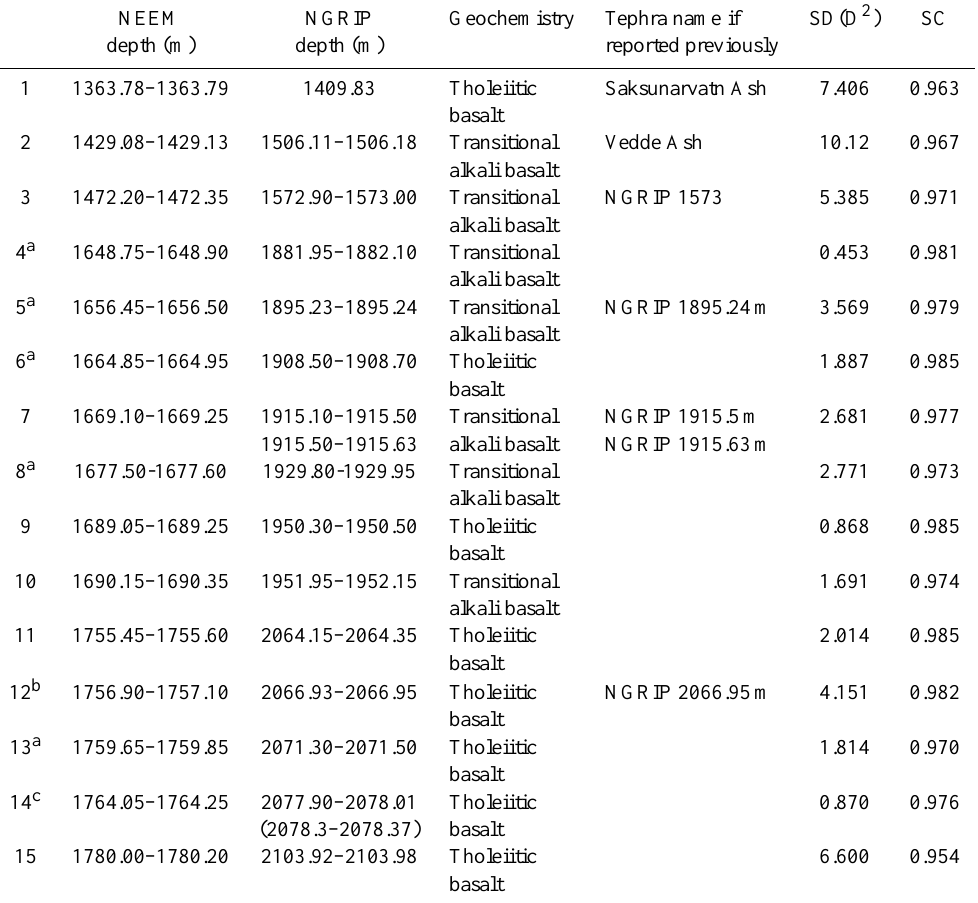
Table 1. Summary table of tephra horizons identified in the NEEM and NGRIP ice cores. Horizons used for the timescale transfer are marked by a , while the other horizons are consistent with the synchronization but not used for the timescale transfer as they are located too close to better-resolved ECM match points. Previously published major element data for NGRIP horizons 1–3 are from Mortensen et al. (2005) and horizons 5 and 7 are from Davies et al. (2010). Major element results for horizons 11–15 are reported in Bourne et al. (2013) and the remaining data sets will be available in forthcoming publications. b The tephra at NGRIP 2066.95m was originally identified by Davies et al. (2010) and new geochemical data reported by Bourne et al. (2013) and used in this work demonstrate that this horizon correlates to NEEM 1756.90–1757.10m. c Major element results for NEEM 1764.05–1764.25m are indistinguishable from two closely-timed tephras in NGRIP (2077.90–2078.01m and 2078.30–2078.37m) (see Fig. 2) and based solely on the geochemical signatures it is uncertain which one is the NGRIP correlative. However, only the correlation to NGRIP 2077.90–2078.01m is consistent with the ECM-based match. The columns SD(D 2 ) and SC provide the statistical distance and similarity coefficient values, respectively (see Sect. 2.4 for further